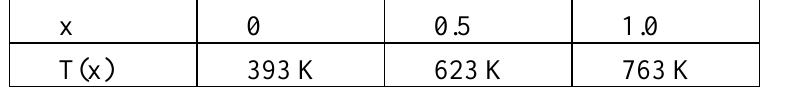
Figure 6. Calculated dependence of the Curie temperature of the system Ba